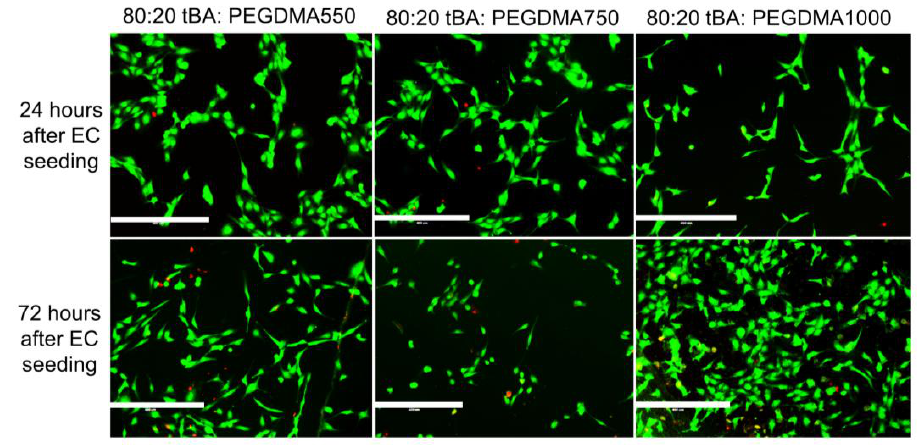
Figure 7. Live Dead Analysis of SMP formulations with highest weight percent (80 wt %) monomer (tBA). Endothelial cell attachment is indicated by the high number of living cells and the low number of dead cells present on the samples. Scale bar = 400 µm.